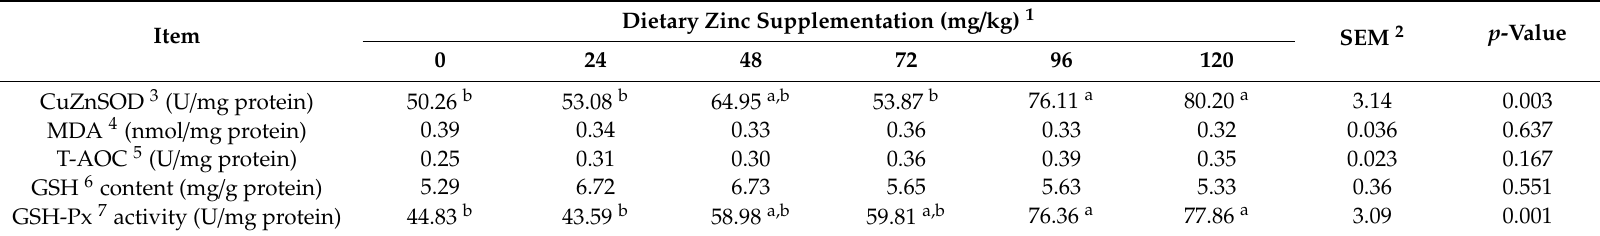
Table 8. E ff ects of dietary zinc supplementation on the ovarian biochemical indices of yellow-feathered broiler breeders aged 65 weeks.